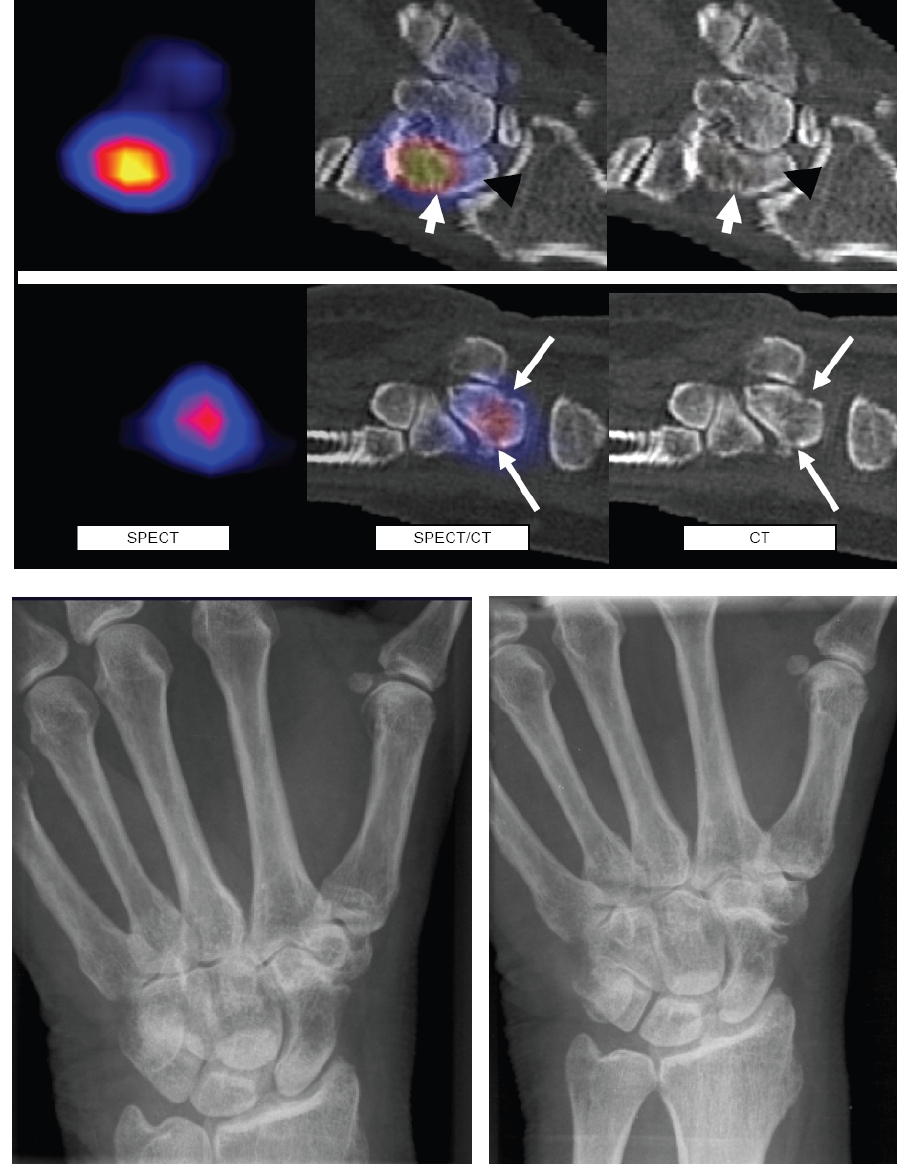
Fig. 2 Traumatic injury 7 weeks ago. No fracture is visible on planar x-ray-images. Strong pain involves the entire forearm including all fingers. The skin is slightly discoloured. The SPECT/CT shows a scaphoid fracture (First line; short white arrow) without fragment dislocation but CT-morphologic sclerosis of the proximal fragment with reduced tracer uptake - indicating osteonecrosis of the proximal fragment (black arrow head). CT and SPECT show no signs of Sudeck’s dystrophia but the additional diagnosis of a fracture of the os triquetrum, seen on SPECT/CT (second line; long white arrows). The scaphoid fracture was seen by all observers. The osteonecrosis of the proximal scaphoid fragment and the additional triquetrum fracture was detected only by SPECT/CT, not in CT or SPECT